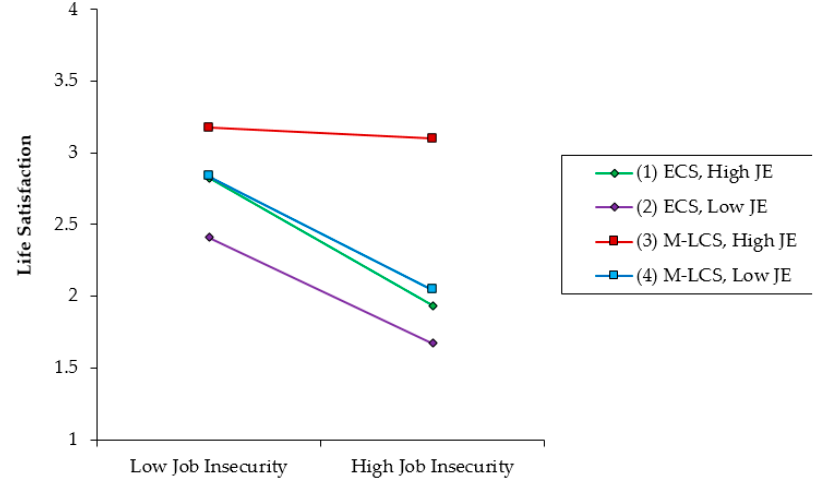
Figure 2. The three-way interaction effects of job insecurity, job embeddedness, and career stage on life satisfaction. Note: JE = job embeddedness; ECS = early career stage; M–LCS = mid–late career stage.